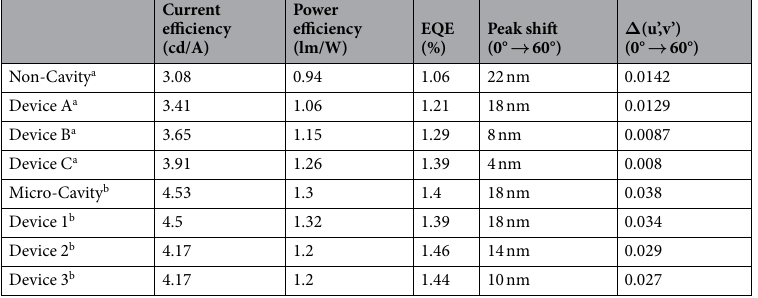
Table 1. Summary of characteristics of OLEDs and MC-OLEDs with diffusion layer. a These devices measured current and power efficiency at 1000 cd/m 2 and EQE at 10 mA/cm 2 . b These devices measured current and power efficiency at 2000 cd/m 2 and EQE at 50 mA/cm 2